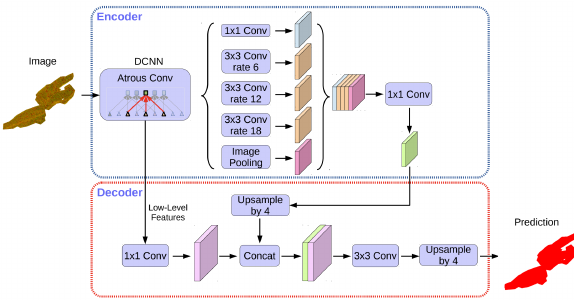
Figure 5: Deeplab v3+ architecture. Best if viewed on